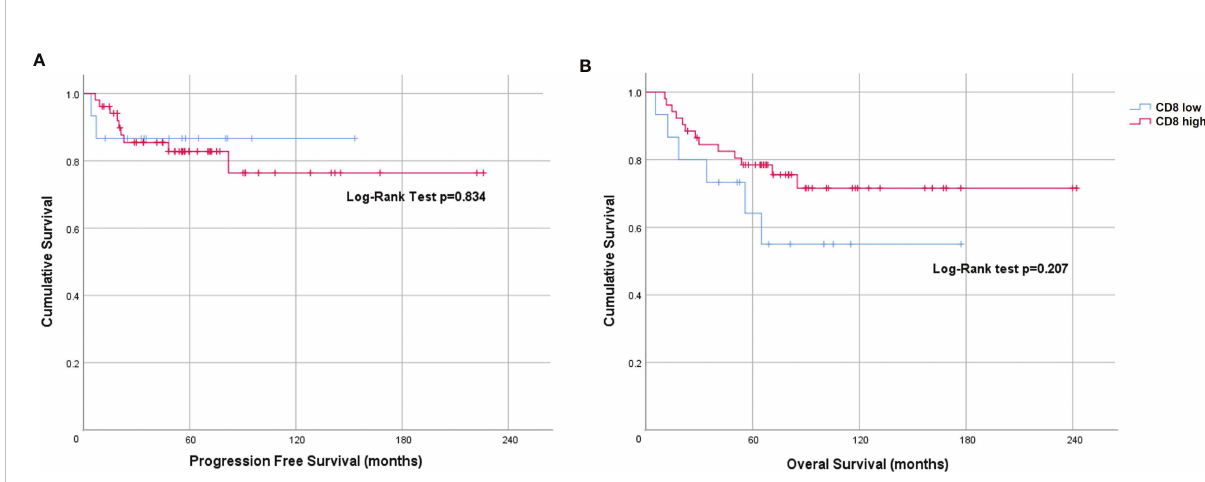
FIGURE 3 Prognostic value of CD8 expression in anal cancer. Kaplan-Meier plots indicating (A) Progression-free survival and (B) Overall survival of patients strati fi ed by CD8 score <2 (low) and ≥ 2 (high).